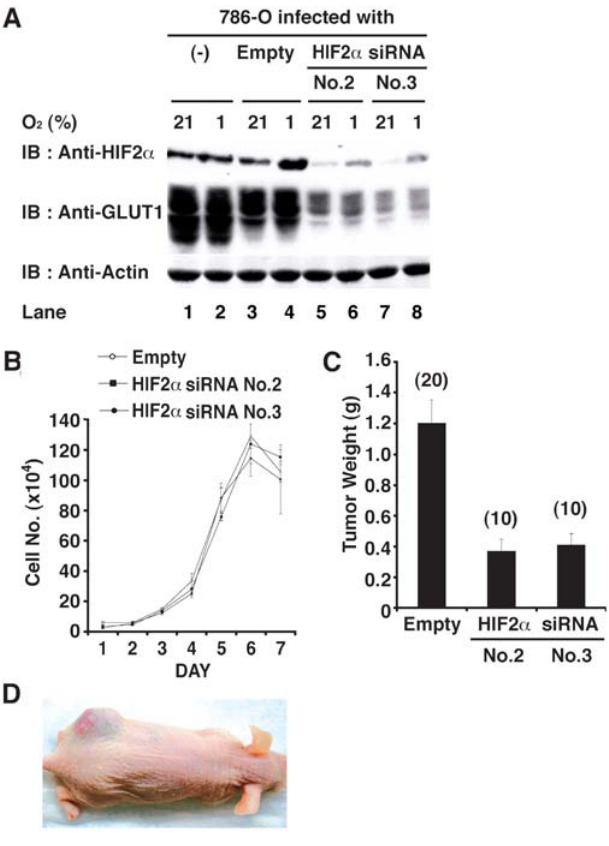
Figure 2. Downregulation of HIF2 a Is Sufficient to Suppress Tumor Growth by pVHL-Defective Renal Carcinoma Cells (A) Parental 786-O cells ( VHL [ (cid:1) / (cid:1) ]) and 786-O cells infected with an empty retrovirus (Empty) or retroviruses encoding HIF2 a shRNAs (sequence #2 or #3) were grown in the presence of 21% or 1% oxygen and immunoblotted (IB) with the indicated antibodies. (B) In vitro proliferation of 786-O cells infected with the indicated retroviruses. (C) Tumor weights approximately 9 wk after subcutaneous implanta- tion of 786-O cells infected with the indicated retroviruses in nude mice. Number of tumors analyzed is shown in parentheses. Error bars ¼ one standard error. (D) Representative photograph of nude mouse 9 wk after subcuta- neous injection of 786-O cells in left (upper) flank and 786-O cells infected with HIF2 a shRNA (#3) retrovirus on right (lower) flank. DOI: 10.1371/journal/pbio.0000083.g002